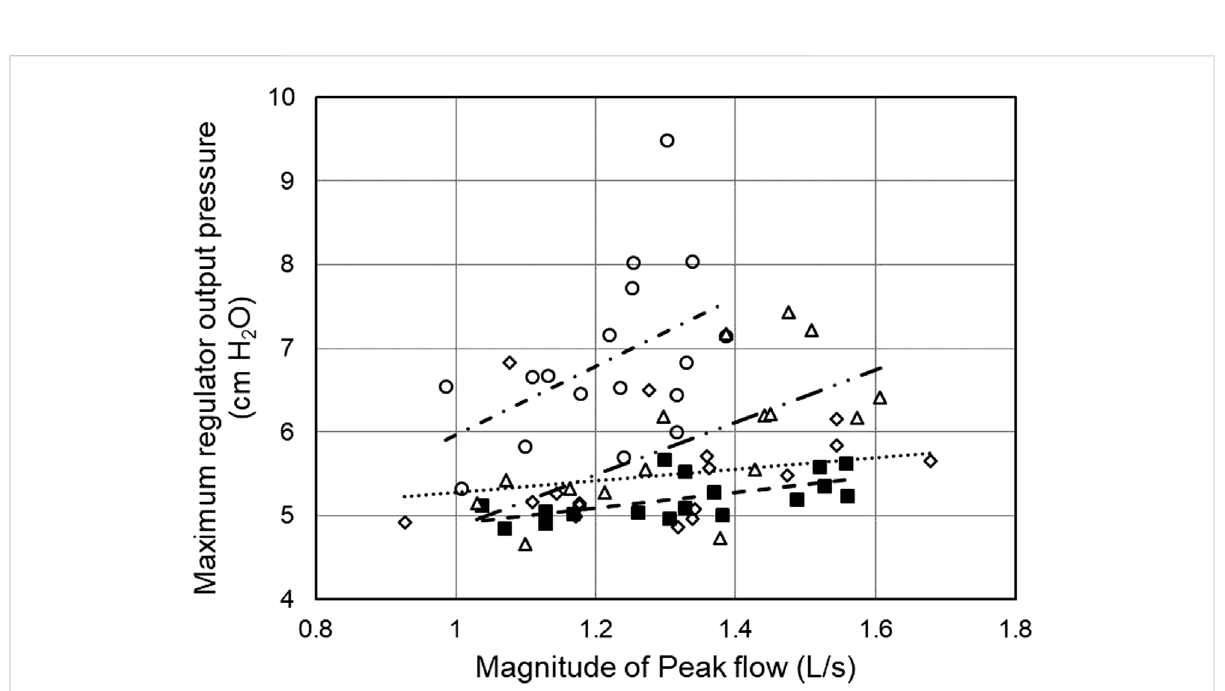
FIGURE 6 Correlationofmaximumregulatoroutletpressurewithpeakinspiratory fl ow.Dataareone-minuteaveragesfromindividualparticipants.Best fi t lines are shown. Conditions: 10 psig ■ and - -; 6 psig ◇ and ··· ; 4 psig, Δ and — · – ; and 2 psig ○ and – · · – . Note that all values shown on the y -axis represent regulator overshoot; the axis starts at 4 cm H 2